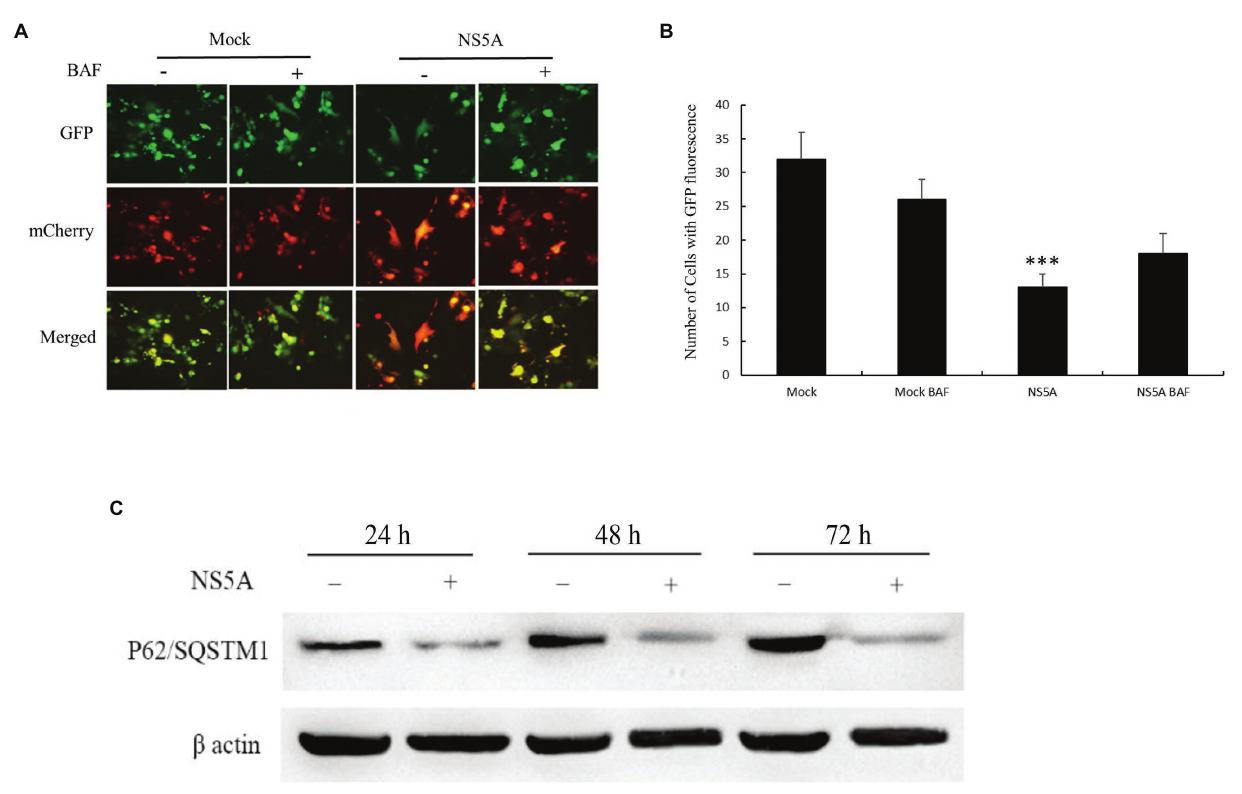
FIGURE 3 | Classic swine fever virus NS5A induces complete autophagy. (A) PK-15 cells were seeded in six-well plates and transfected with mRFP-eGFP-LC3 only or cotransfected with NS5A and mRFP-eGFP-LC3. The cells were incubated for 48 h, after which they were treated with or without 0.2 μ M autolysosome inhibitor bafilomycin A1 (BAF) for 12 h before fluorescence imaging. (B) Analysis of the number of cells expressing GFP protein. (C) Analysis of P62/sequestosome 1 (SQSTM1) degradation in PK-15 cells transfected with or without NS5A. The cell lysates were harvested at the indicated time points and subsequently analyzed by Western blotting by probing with anti-P62/SQSTM1 antibodies. GAPDH served as a loading control for all analyses. The data represent the mean ± SD of three independent experiments. Statistical comparisons were evaluated using ANOVA followed by Tukey’s HSD post hoc analysis. *** p < 0.001, compared with the mock